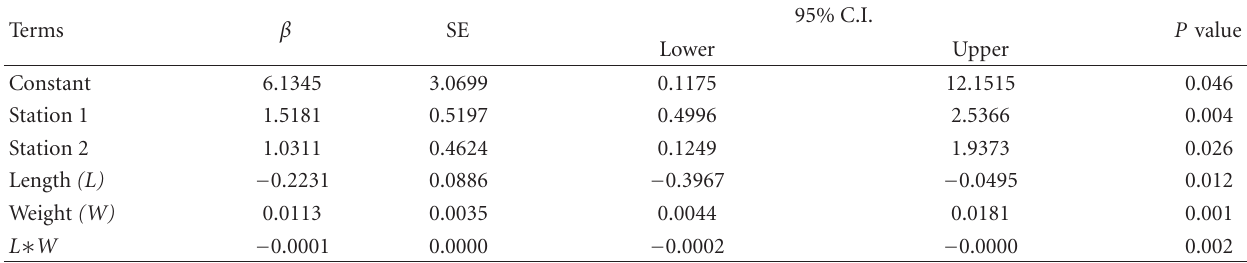
Table 3: Parameter estimates, for the model of prevalence of Pseudoterranova larvae in cod ( Gadus morhua ) from the three catch stations. Cod from catch station 3 was used as reference point.